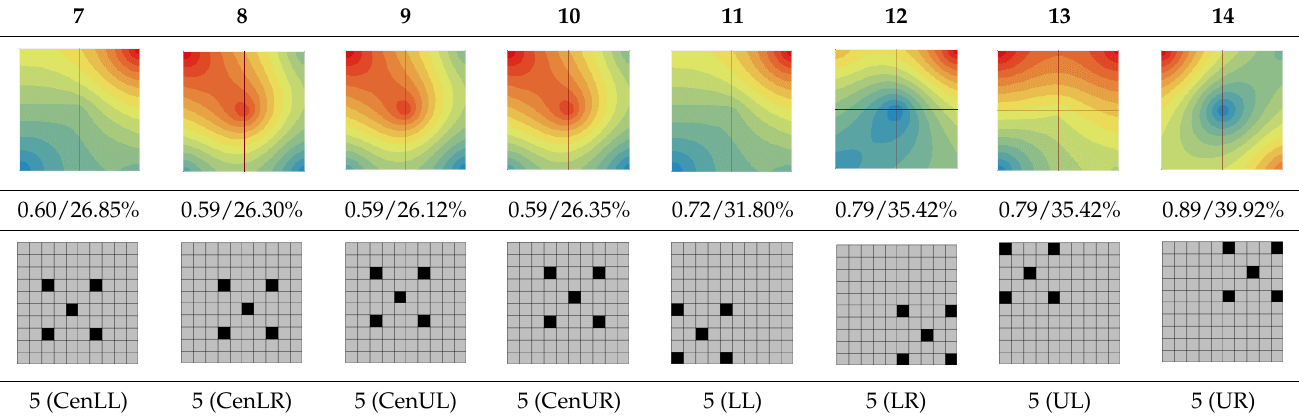
¶ The black and gray boxes show the training and testing samples for cokriging model derivation and accuracy evaluation, respectively. The surface fuel load map for the particular area bounded by the training samples was first generated through the cokriging semivariogram model and then extended to the extent defined by templates no. 7–14. The xx/xx% values below each map specify the RMSE/PRMSE that was derived from the corresponding template.